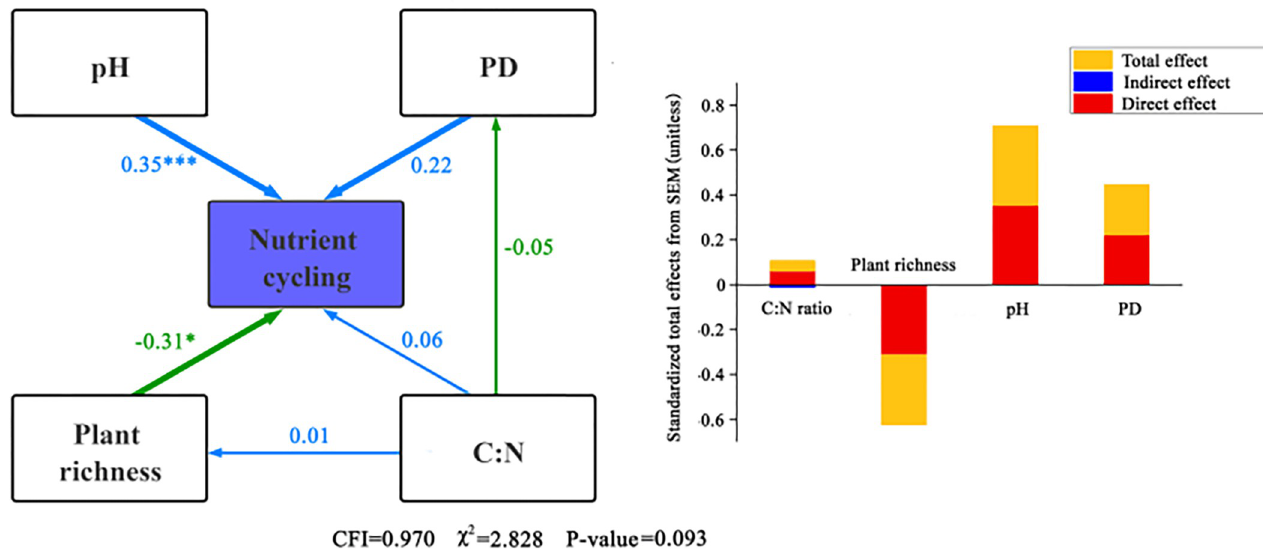
Fig 4. A structural equation model of the relationship between plant diversity, abiotic factors, and nutrient cycling. The blue and green arrows indicate positive and negative relationships, respectively. The width and strength of the arrow are proportional. The number near the arrow is the normalized path coefficient, reflecting the magnitude of the effect of causality. The significance level is as follows: � P < 0.05, � P < 0.001, the same as below.